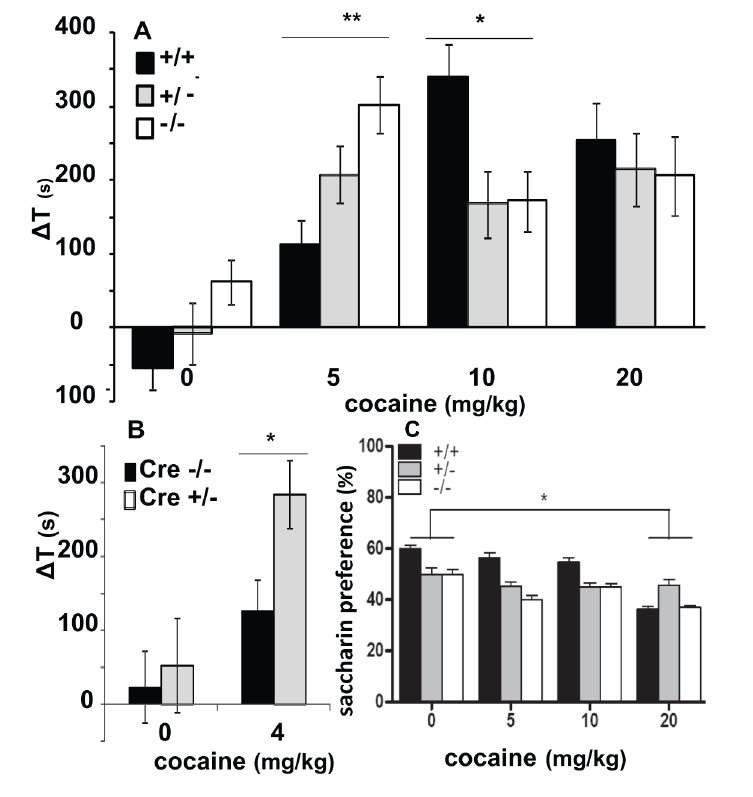
Figure 1. Constitutive (A, C) and adult (B) CDH13 knockout alters conditioned place preference (A, B) but not conditioned taste aversion (C) provided by modest to moder- ate cocaine doses. (A, B) Mean difference ± SEM in time spent on the cocaine-paired side before and after conditioning (n = 1 –12/group). There was no significant difference between genotypes in time spent on the drug-paired side during the pre-tests for con- stitutive (ANOVA, p = 0.740) or conditional ( p = 0.542) knockouts. (C) Preference for cocaine-paired saccharin solution in two bottle testing after taste aversion